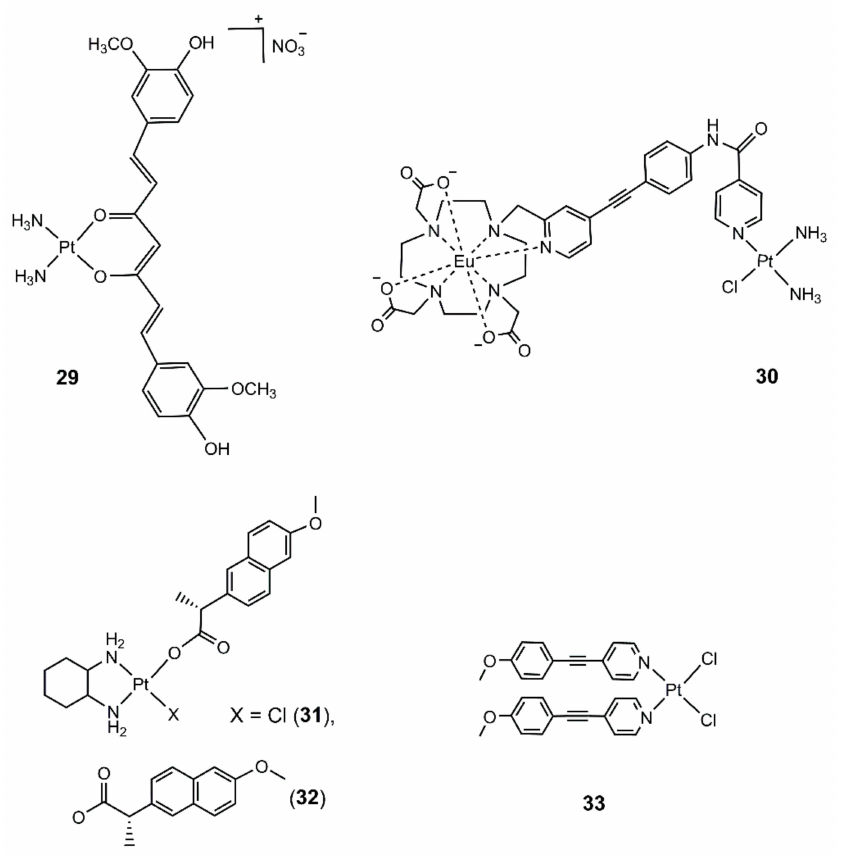
Figure 6. Chemical structures of photodissociation Pt(IV)